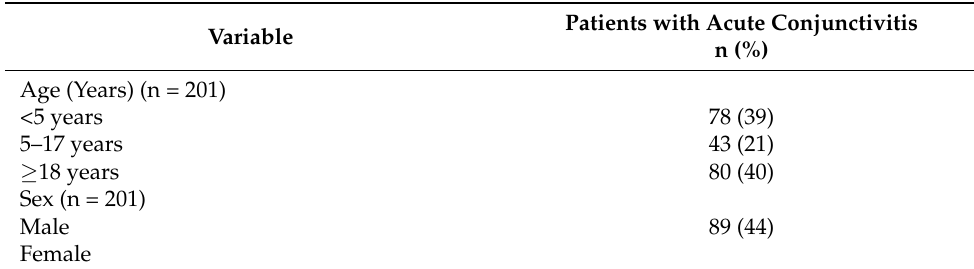
Table 1. Socio-demographic characteristics of patients presenting with acute conjunctivitis at a specialist eye hospital in Ghana from 1 January to 31 December 2021.